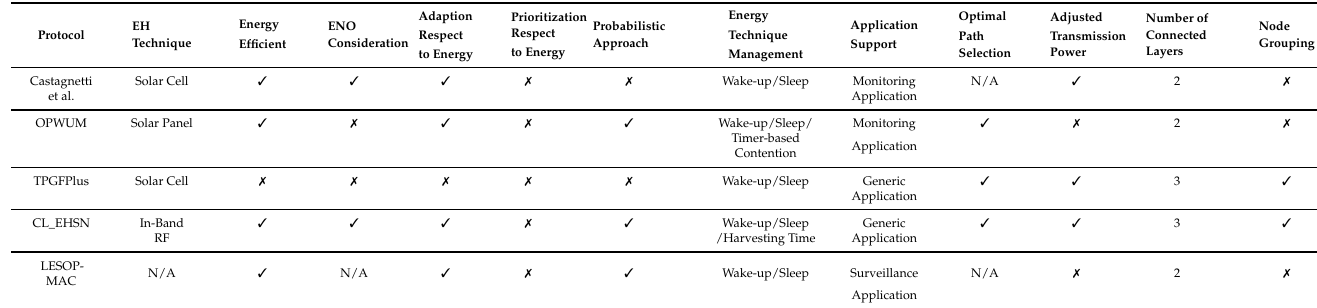
Table 10. Comparison of cross-layer energy harvesting MAC